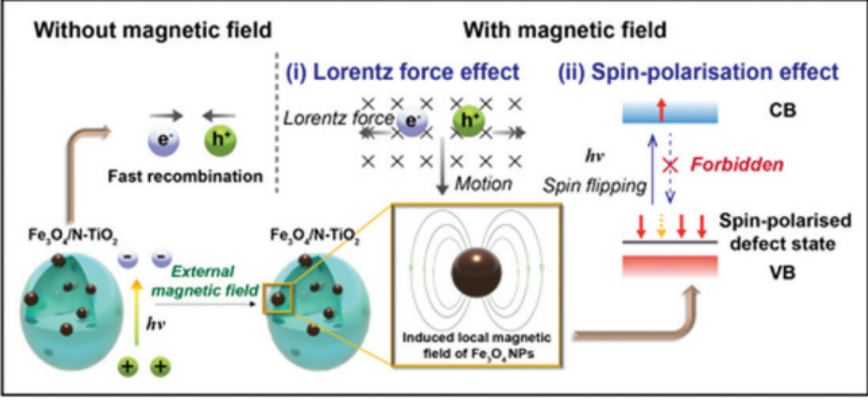
Figure 22. Schematic diagram of magnetic field-promoted photocatalytic water splitting system (Reprinted/adapted with permission from Ref. [217]. Copyright 2022, copyright Royal Society of Chemistry).